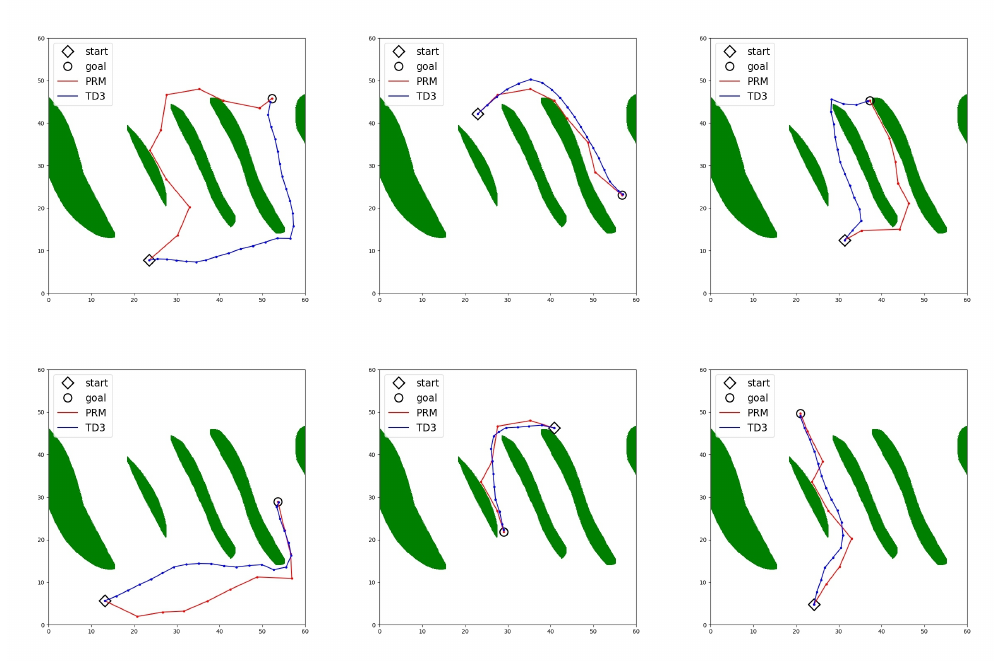
Figure 7. DDPG based path generation for arbitrary starting and goal points in C-space.